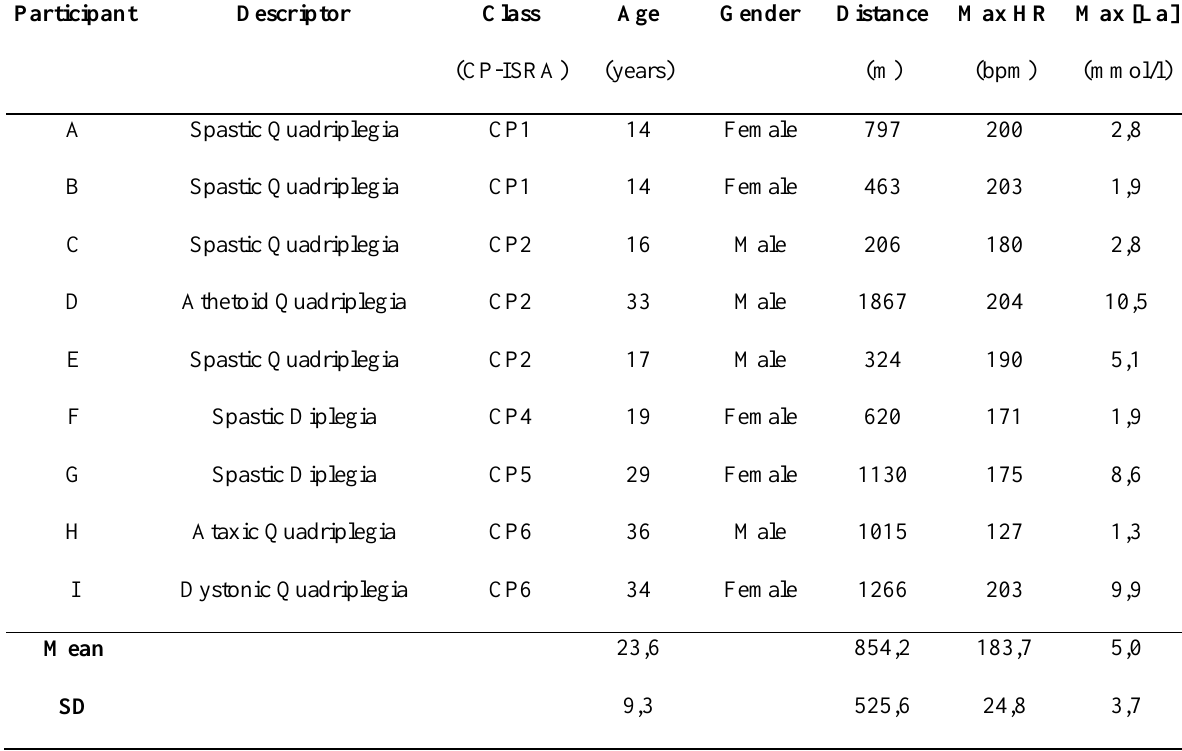
Participant characteristics and the results of the Cooper test